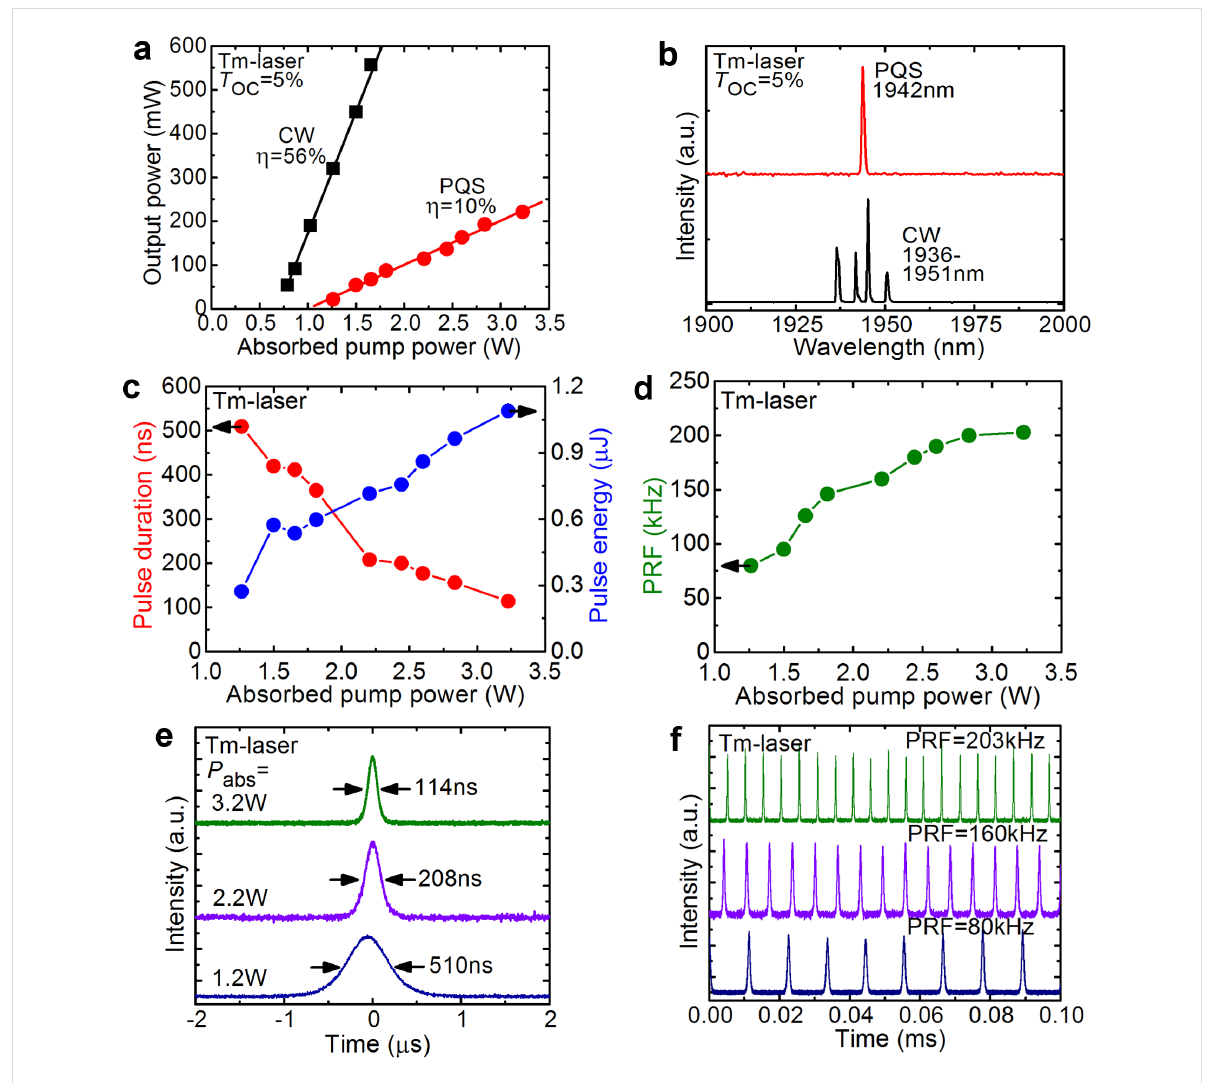
Figure 5: Tm:KLuW laser: CW operation and passive Q-switching by ZnO NRs grown for 5 h: (a) input–output dependences, η – slope efficiency (the data for PQS operation are adapted from [28]); (b) typical laser emission spectra measured at the maximum P abs ; (c) pulse duration and pulse energy, adapted from [28]; (d) pulse repetition frequency (PRF); (e,f) typical oscilloscope traces of (e) single Q-switched pulses and (f) the corre- sponding pulse trains for different P abs (the pulse train corresponding to a PRF of 203 kHz is adapted from [28]).